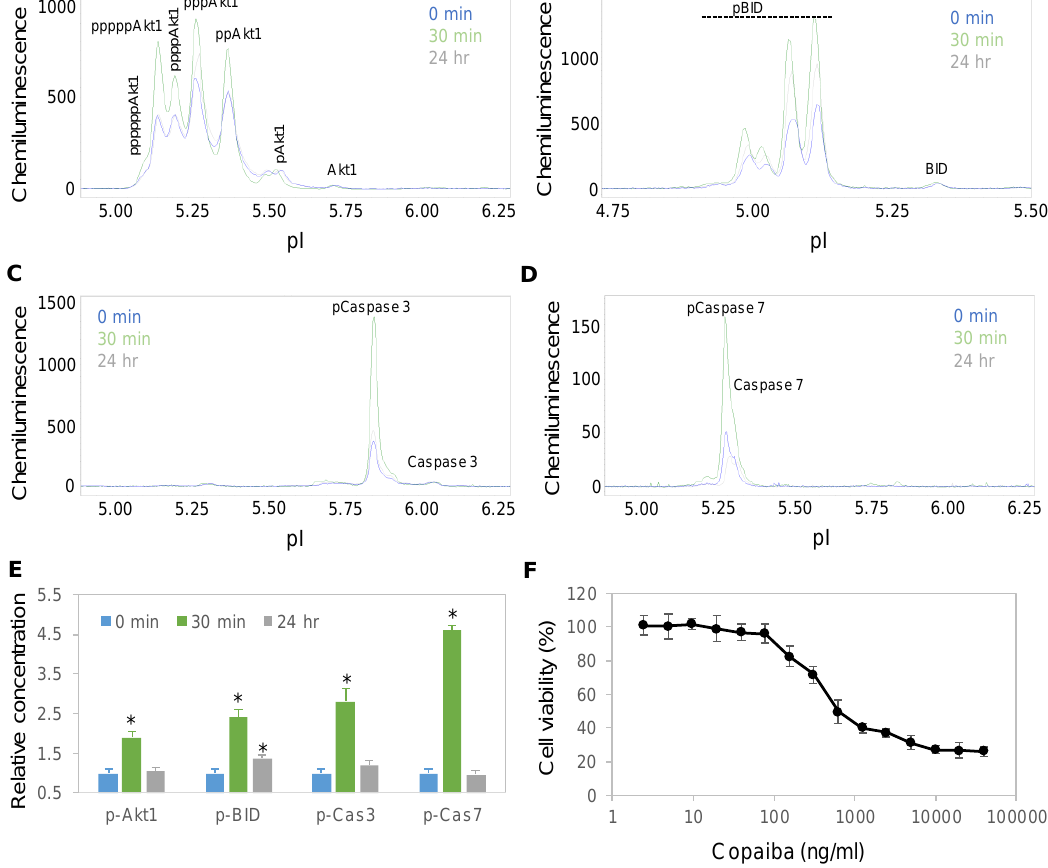
Figure 6. Time-dependent positive regulation of the apoptosis signaling pathway by copaiba essential oil. ( A–D ) Akt1 ( A ), BID ( B ), caspase 3 ( C ), and caspase 7 ( D ) profiles as functions of time after treatment of SH-SY5Y cells with 100 ng / mL copaiba essential oil. ( E ) Relative concentrations of p-Akt1, caspase 3, and caspase 7 as functions of time after treatment with 100 ng / mL copaiba essential oil for 0 min (blue), 30 min (orange), and 24 h (gray). ( F ) Viability percentages of SH-SY5Y cells as functions of the concentrations of copaiba essential oil. The relative concentration describes the fold change in a protein phosphoisoform after treatment compared to the control condition. The error bars are the standard deviations of six repeated measurements per experimental condition. The asterisks indicate statistical significance for p ≤ 0.05 versus the control.